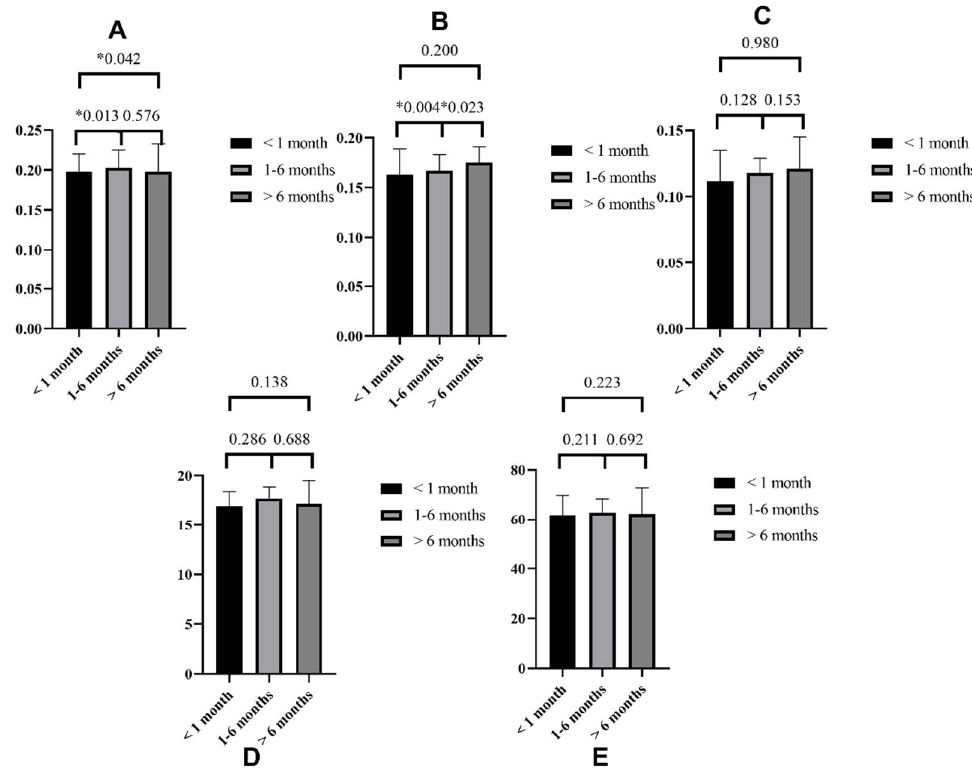
Figure 3. Differences in SS-OCT/OCTA parameters among three groups based on the disease dura-